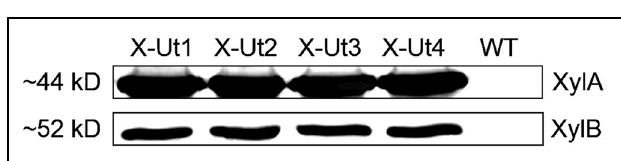
FIGURE 5 | Immunodetection of xylose catabolic proteins. Protein samples extracted from Synechocystis transformant strains, X-Ut1, X-Ut2, X-Ut3, and X-Ut4 and the WT strain as the negative control were probed with specific polyclonal antibodies for the XylA ( D -xylose isomerase) and XylB ( D -xylulokinase) enzymes. Each lane was loaded with 20 μ g of total protein fraction. The expected molecular masses for XylA and XylB proteins are indicated.